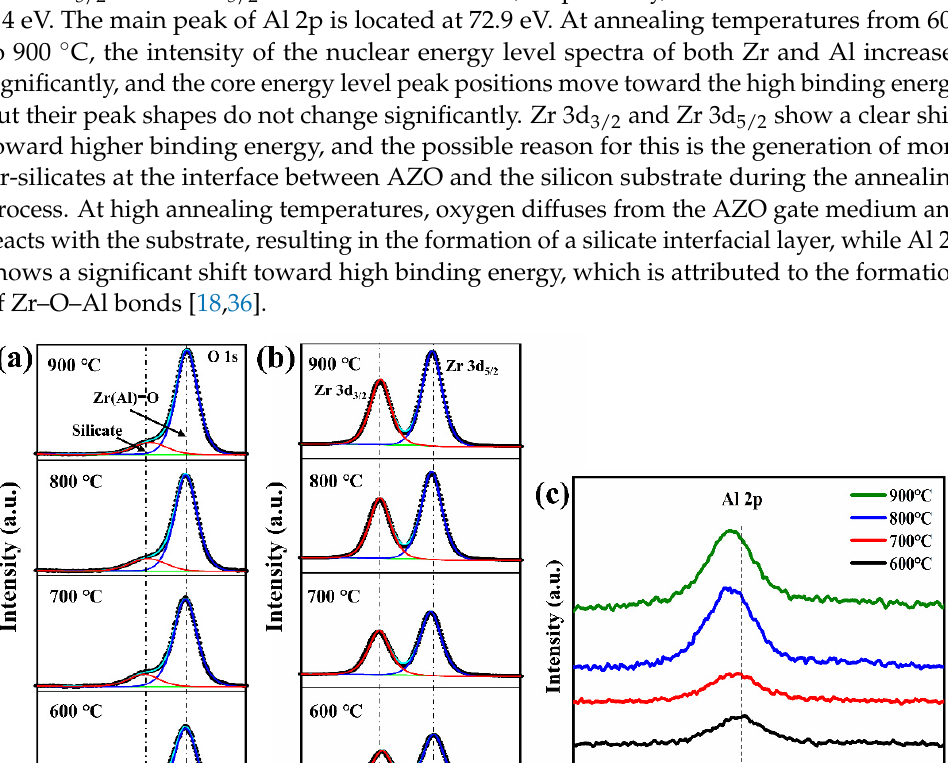
Figure 5. Transmittance profiles of AZO films at different annealing temperatures. Clearly, the determinants of gate leakage current levels in CMOS devices are inextri- cably linked to bandgap size, valence band, and conduction band offsets and can also be used as physical factors to evaluate high-k gate dielectrics [37]. Based on the transmittance data of AZO films, the standard Tauc plot formula is as follows[38]: α h ν = A (hν − 𝐸 (cid:3034) ) (cid:2869)/(cid:2870) , where α is the absorbance index, h is Planck’s constant, ν is the optical frequency, A is a constant, and E g is the semiconductor forbidden bandwidth. The bandgap size of the AZO film is calculated, and the calculation results are tallied in Figure 6. From the figure, the